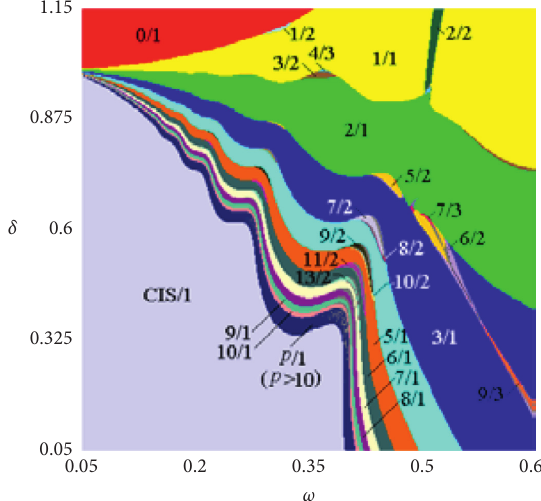
Figure 20: Periodic motions on the ( ω , δ ) -parameter plane associated with each constraint when δ (b) constraint A 12 ; (c) constraint A 2 .